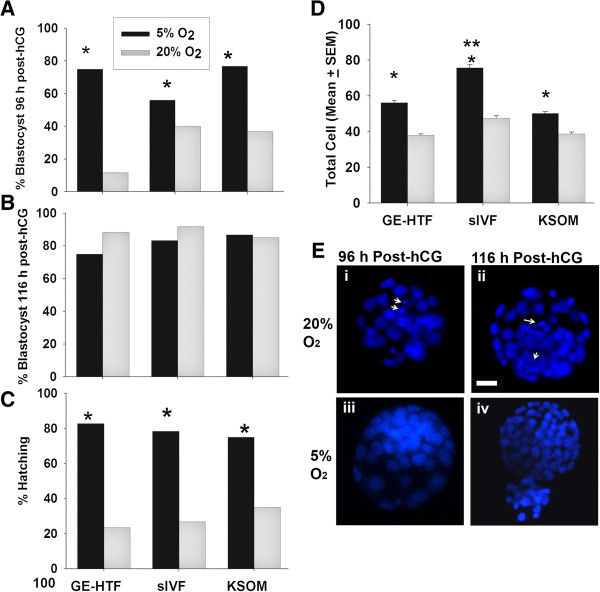
The effect of O2 tension on growth rate. Hybrid strain zygotes were cultured as 10 embryos in a drop of 10 μL GE-HTF medium, sIVF or KSOM media. The rates of blastocyst formation (A) 96 h and (B) 116 h post-HCG, (C) the rate of hatching blastocysts and (D) the cell number in the resultant blastocyst (116 h post-hCG) were analysed. Each treatment contained at least 80 embryos from two independent replicates. *p < 0.001, compared to the embryos cultured in 20% O2. **p < 0.001, compared to modHTM or KSOM media in 5% O2. (E) Representative images of embryos developed in different O2 tension stained with Hoechst 33342 and examples of fragmented nuclei shown with arrows.